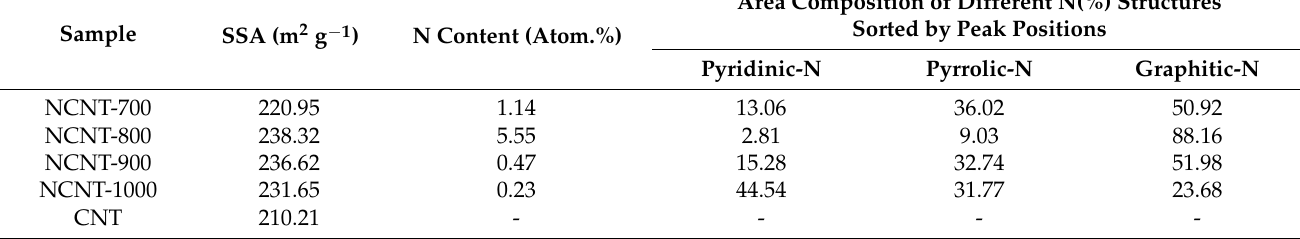
Table 2. Types and contents of nitrogen binding